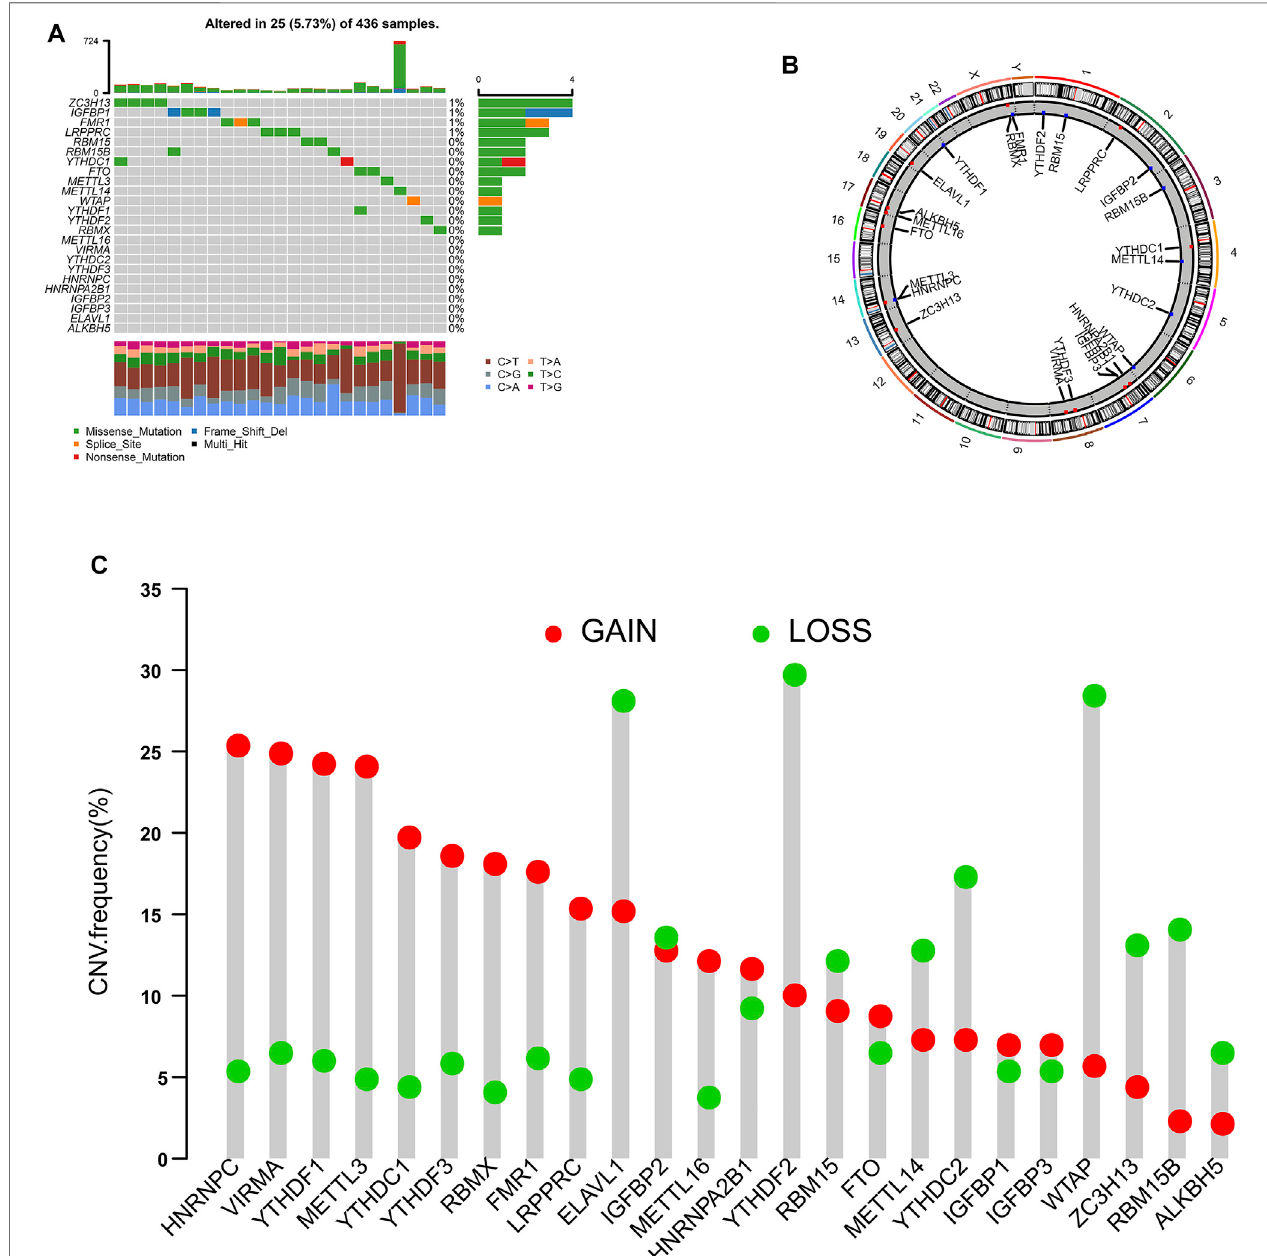
FIGURE 1 | Landscape of genetic variation of m6A regulators in ovarian cancer. (A) The mutation frequency of 24 m6A regulators in patients with ovarian cancer from TCGA cohort. (B) The location of CNV alteration of m6A regulators on 23 chromosomes using TCGA cohort. (C) The CNV variation frequency of m6A regulators according to TCGA